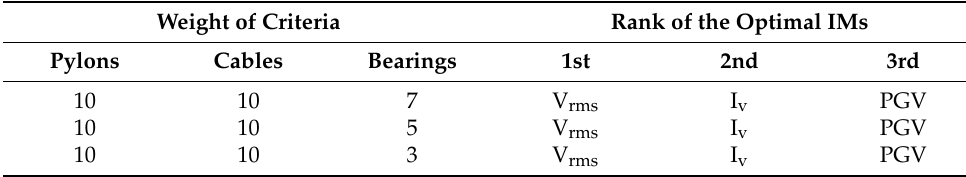
Table 6. Results of the MCDM method.